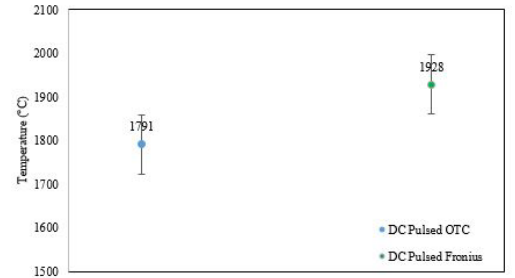
Figure 12. Weld pool temperature - Fronius and OTC Pulsed